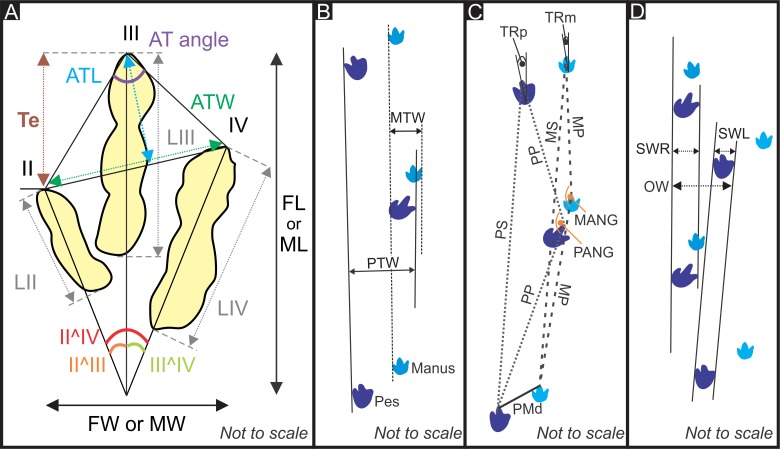
Schematic diagram showing the various track and trackway parameters measured.(A) Measurements taken on individual footprints. (B) Manus and pes trackway widths (MTW, PTW). (C) Trackway measurements. (D) Parameters used to quantify trackway gauge recommended by Romano et al. [71]. See methods text for a full list of abbreviations used.